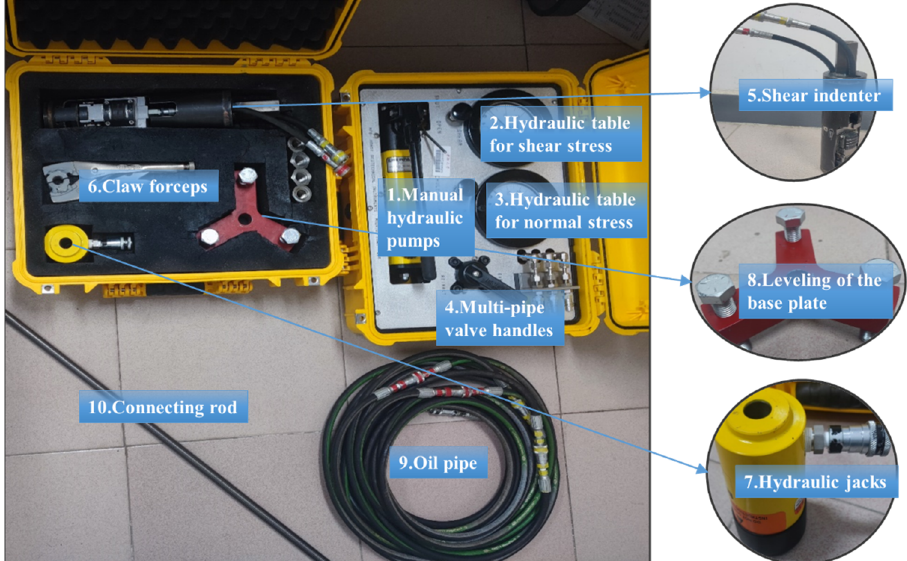
Figure 1. Rock in situ shear. (1.) Manual hydraulic pumps (2.) Hydraulic table for shear stress (3.) Hydraulic table for normal stress; (4.) Multi-pipe valve handles (5.) Shear indenter (6.) Claw forceps (7.) Hydraulic jacks (8.) Leveling of the base plate (9.) Oil pipe (10.) Connecting rod.